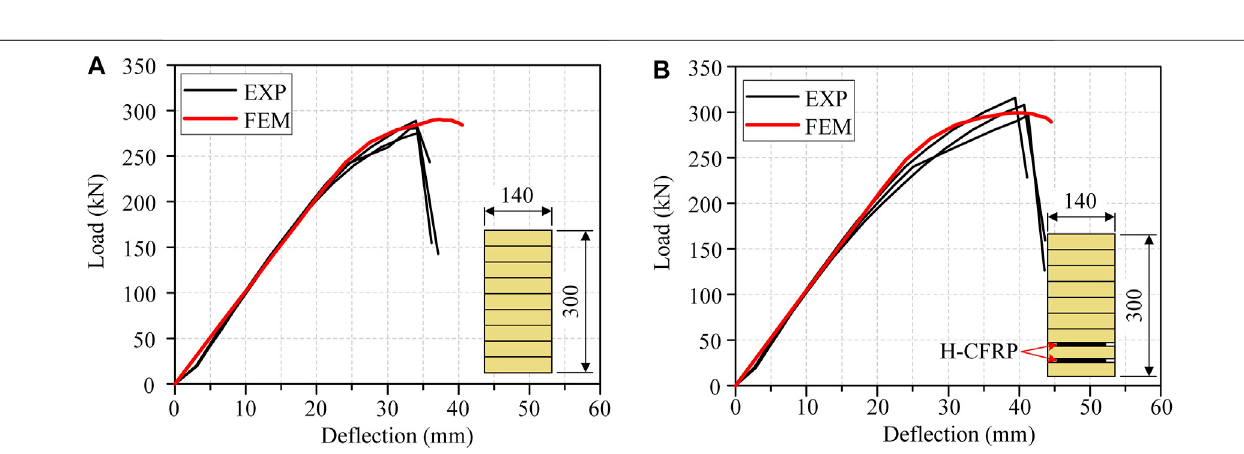
TABLE 6 | Comparison of the numerical results to the experimental results. Group M u (kN · m) E app I (kN · m 2 ) Experimental results Numerical results Difference (%) Experimental results Numerical results Difference (%)